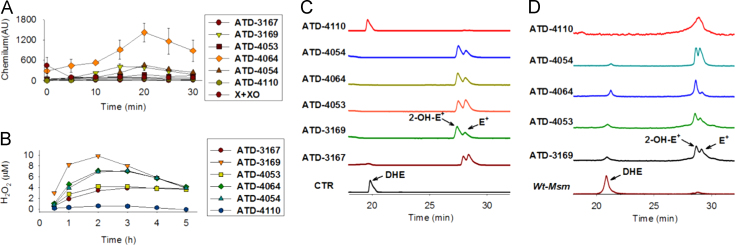
(A) The time course of superoxide radical anion (O2−•) generation during incubation in pH 8.0 buffer over 30 min was studied by a luminol chemiluminescence assay. (Note: X+XO generates O2−• rapidly, typically <1 min). (B) Time course of hydrogen peroxide (H2O2) generated during incubation of Wt-Msm with 10 µM of the compound in pH 7.4 was estimated using an Amplex Red fluorescence assay. (C) A HPLC-based dihydroethidium (DHE) assay was used to infer generation of O2−• after incubation of compounds (50 µM) in pH 8.0 buffer for 1 h. 2-Hydroxyethidium (2-OH-E+), which is exclusively formed by the reaction of O2−• with DHE, elutes at 28.6, and ethidium E+, which is formed by nonspecific oxidation of DHE, elutes at 29.5 min. (D) HPLC traces of assay for intracellular O2−•production using a dihydroethidine (DHE) assay in Mycobacterium smegmatis (Wt-Msm). Incubation with compounds (50 µM) was for 30 min and DHE levels indicate unoxidized dye while 2-OH-E+ formed is an indicator for O2−• production and E+ is indicative of increase in oxidative species.